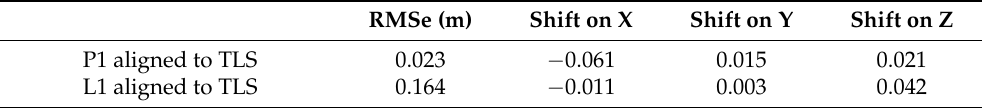
Figure 20. Profile 1 ICP alignment. L1 (cyan) aligned with SX10 data (red): ( a ) before the alignment; ( b ) after the alignment. Table 12. Section no. 1—ICP registration and alignment: P1 and L1 data aligned with TLS